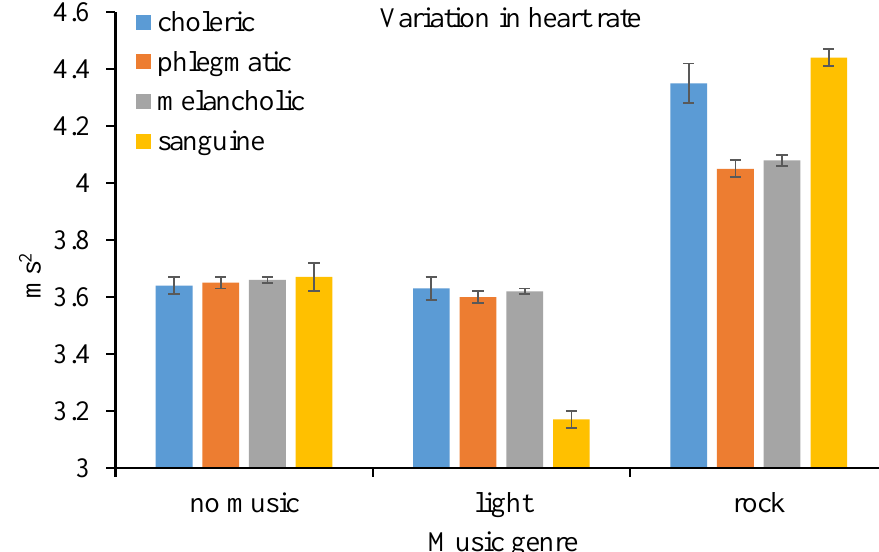
Figure 3. Variation in heart rate (and standard error) by music genre and personality.